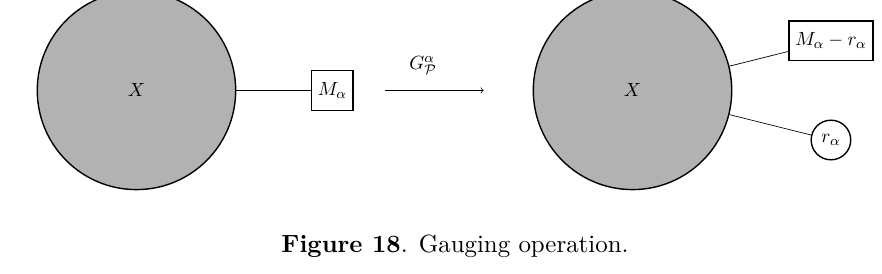
Figure 18 . Gauging operation.